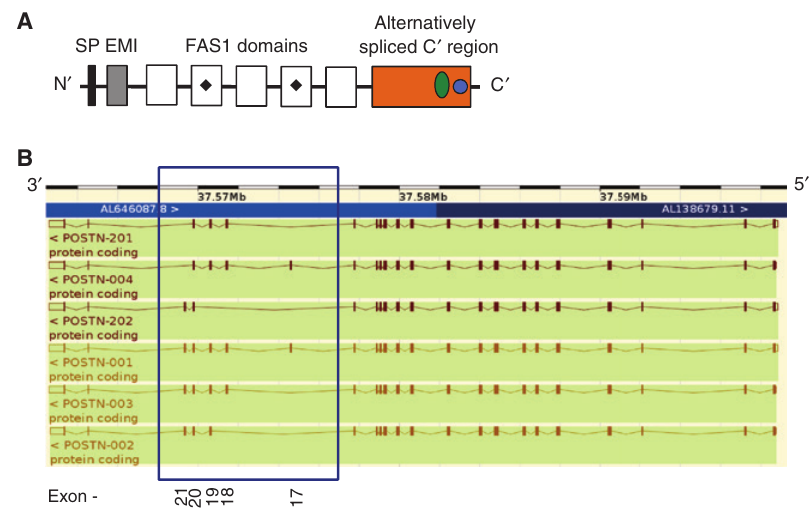
Figure 3: Alternative splicing of the human periostin gene ( POSTN ) and associated protein domains. (A) The periostin protein consists of a signal peptide (SP) that targets the protein for secretion, a cysteine-rich EMI domain, and four fasciclin-like 1 (FAS-1) repeats. The second and fourth FAS1 domains contain integrin binding domains (black diamonds). The alternatively spliced C ′ region (shown in orange) has no known functional domains and appears to be intrinsically disordered. The functional effect of alternative splicing is therefore difficult to predict. However, there are predicted heparin binding domains in the C ′ tail (blue circle), and also an anomalous nuclear localisation signal (green oval) (105, 106). Diagram is not to scale. (B) The ENSEMBL database identifies six alterna- tive protein coding transcripts for POSTN , resulting from the alternative splicing of five exons towards the 3 ′ end of the coding sequence (blue box). Additional splice variants identified in the NCBI Gene database are given in Table 4. All databases accessed in November 2015.